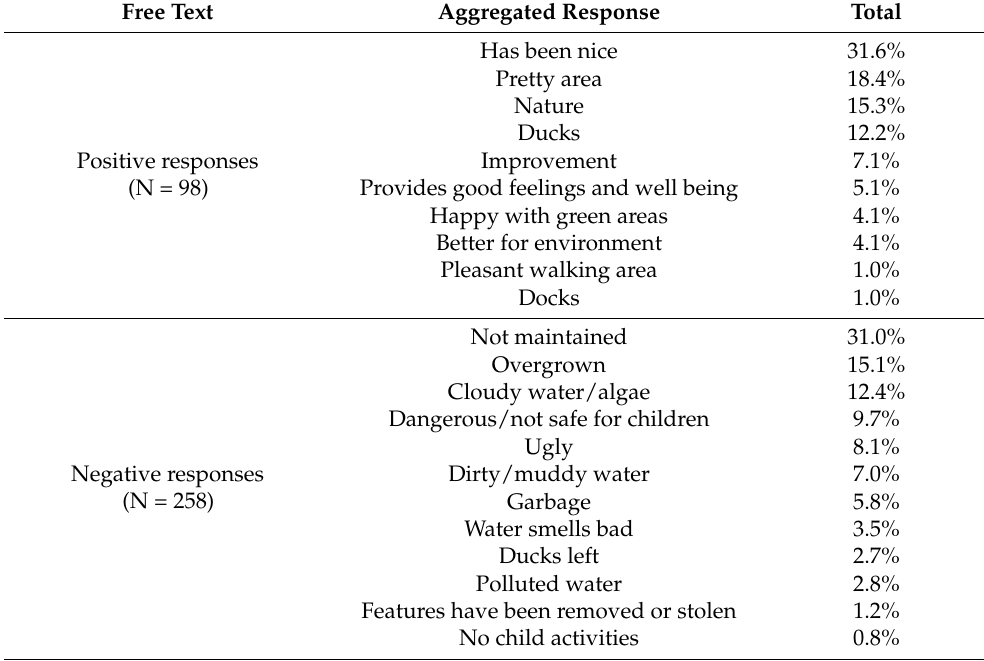
Table 3. Positive responses, negative responses and potential improvements in free